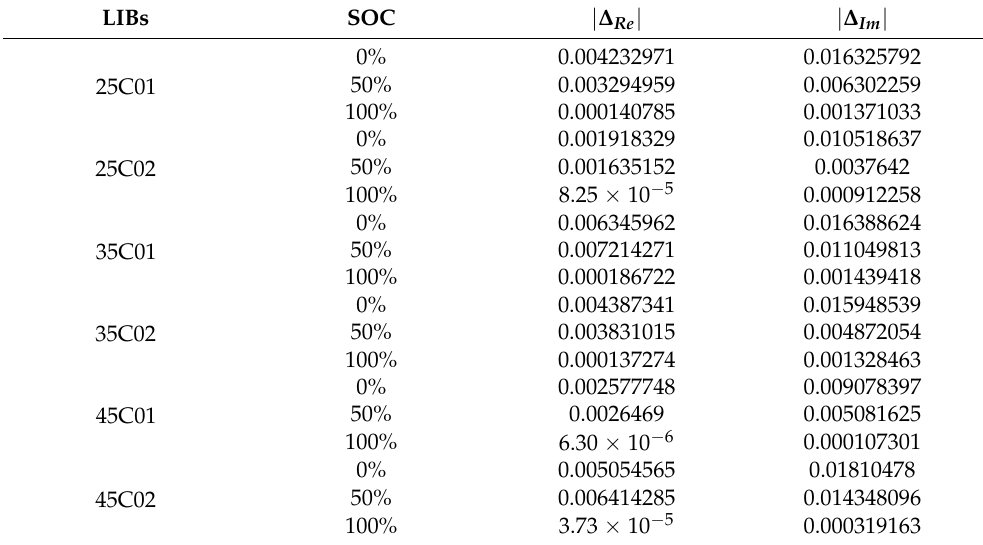
Table 3. Lin–KK test mean residual (mean values of fitted residuals for EIS data at all cycles of